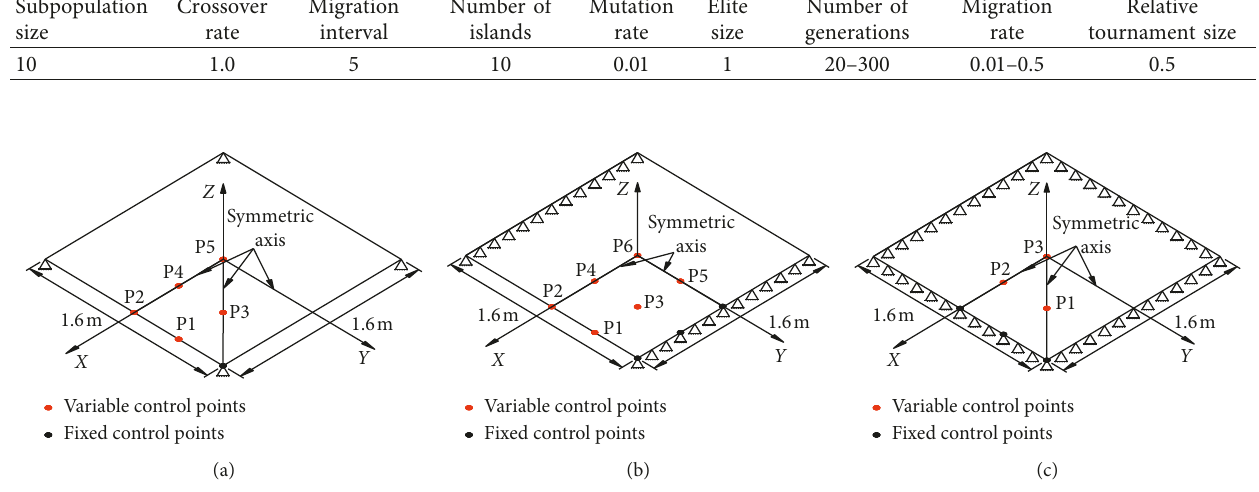
Figure 4: Geometry of shells and corresponding location of control points in Example 1. (a) Shell 1. (b) Shell 2. (c) Shell